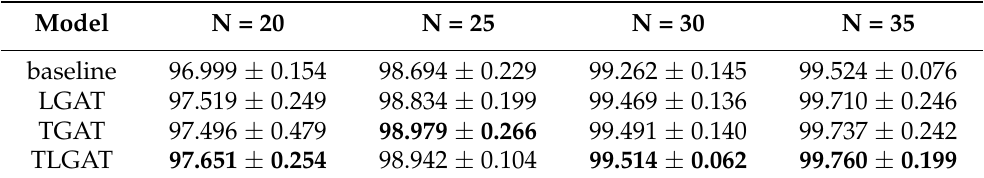
Table 7. The overall F 1 - score ( % ) (mean ± 3 σ ) of TLGAT, LGAT, TGAT, and baseline in the ARUBA